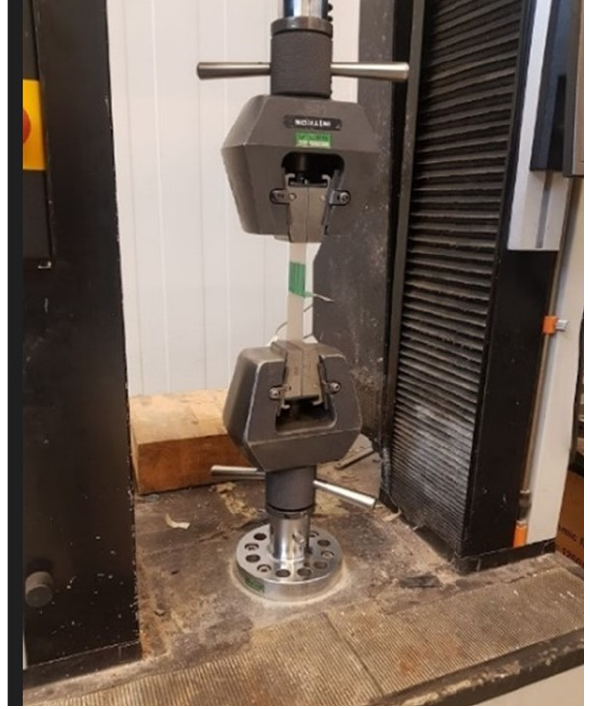
Figure 9. Instron test machine for measuring the adhesive strength.